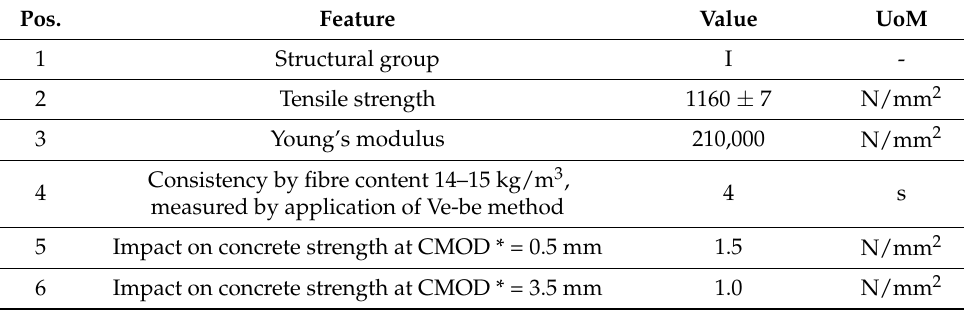
Table 1. Technical characteristics of the steel fibres used in the tests ([55,56]).